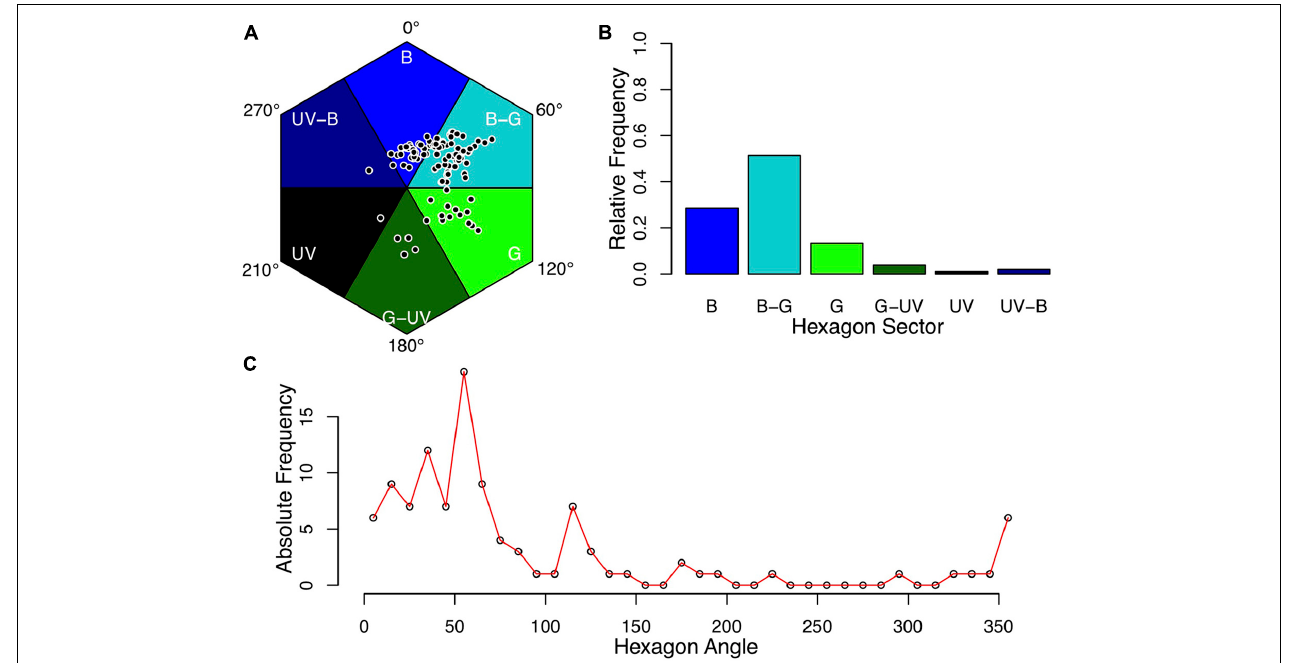
FIGURE 1 | Flower colors of alpine flowering plants. Mean color loci of bumble bee visited plant species for which full nectar data and spectral measurements were available ( N = 105). (A) Color loci plotted in the hexagon color space. (B,C) Frequency of samples in color categories at a rough (B) and fine (C) scale (B, blue; B-G, blue-green; G, green; G–U, green-UV; UV, UV; UV-B, UV-blue). Colors assigned to the categories are for illustrative purposes and are not intended to reflect human or bee-specific perception. The convention for hexagon angle measurement is indicated in panel (A) .